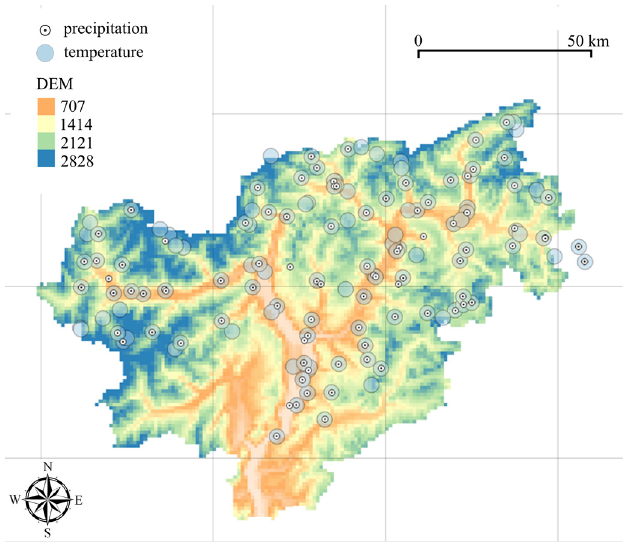
Figure 2. Available measurement stations in South